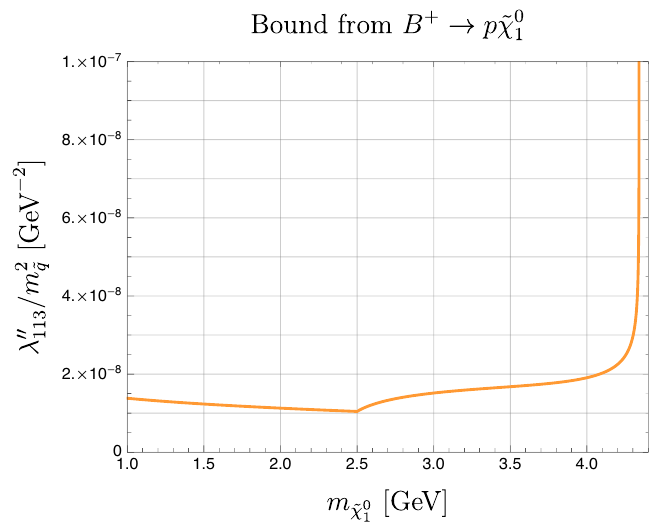
Figure 8 . Upper bounds on λ 00 /m 2 as a function of the neutralino mass, extracted from the 113 ˜ q process B + → p ˜ χ 0 , assuming the sensitivity given in section 1